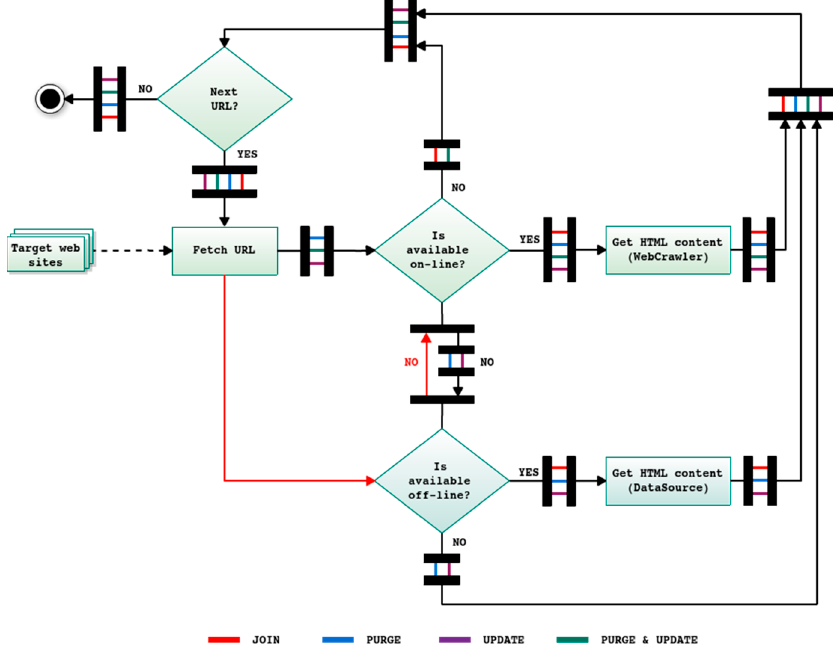
Figure 2. Detailed WARCProcessor operation mode for each task.